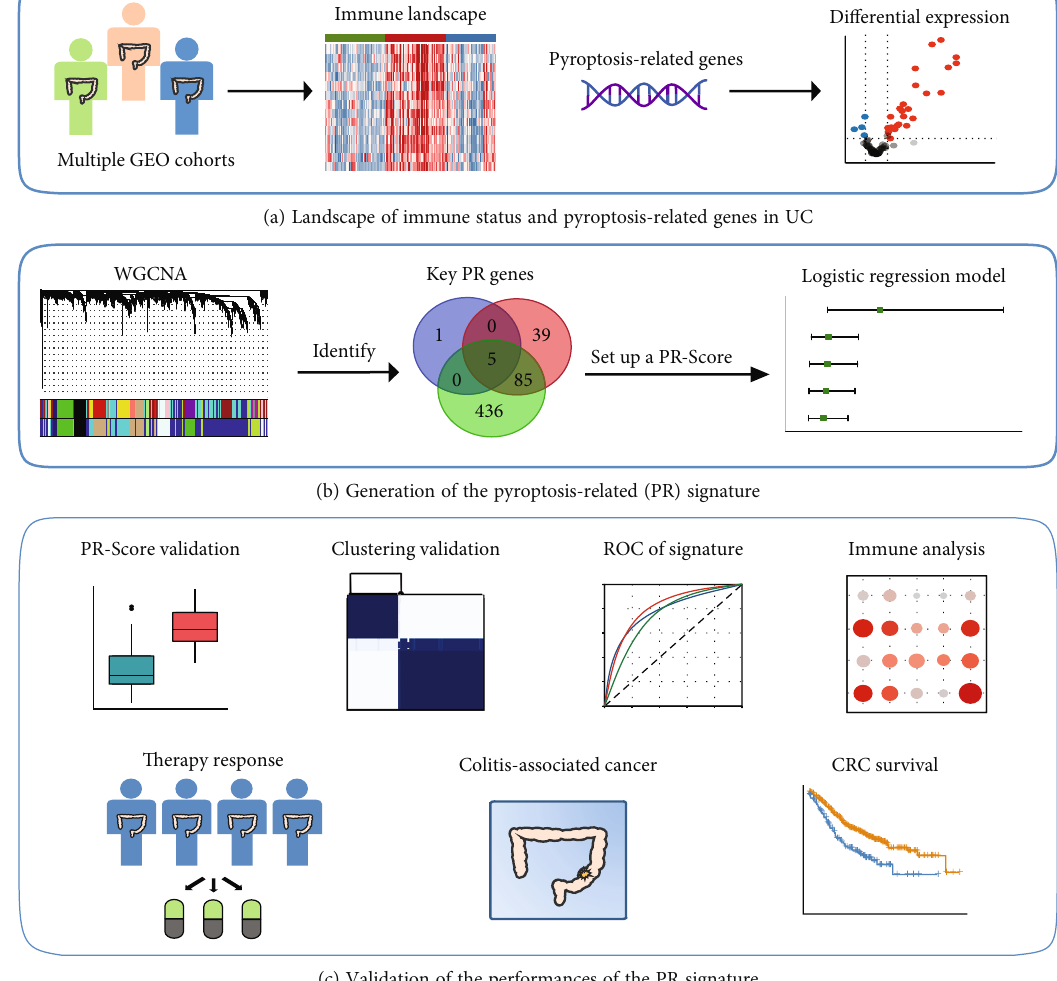
Figure 1: Research fl ow chart of this study. UC: ulcerative colitis; GEO: Gene Expression Omnibus; PR: pyroptosis-related; WGCNA: weighted gene coexpression network analysis; ROC: receiver operating characteristic; CRC: colorectal